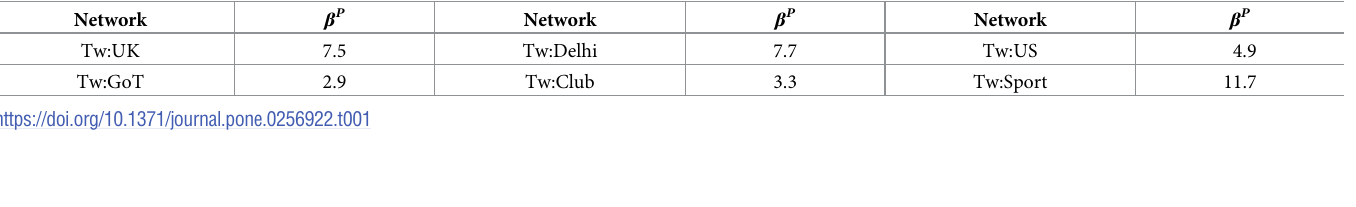
Table 1. β P for real-world twitter datasets.